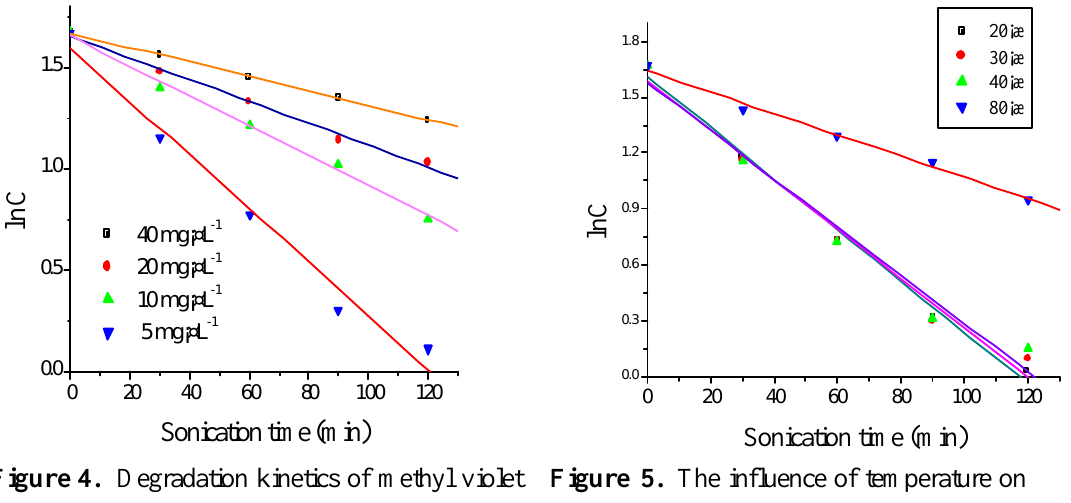
Figure 4. Degradation kinetics of methyl violet Figure 5. The influence of temperature on for different initial concentrations at the ultrasonic degradation rate of 20°C. methyl